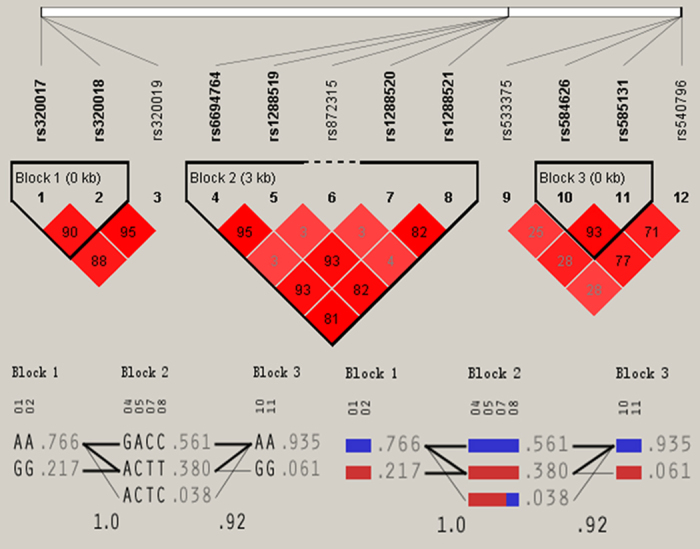
The LD plot represents pair-wise r2 and haplotypes frequency in the Jing population.